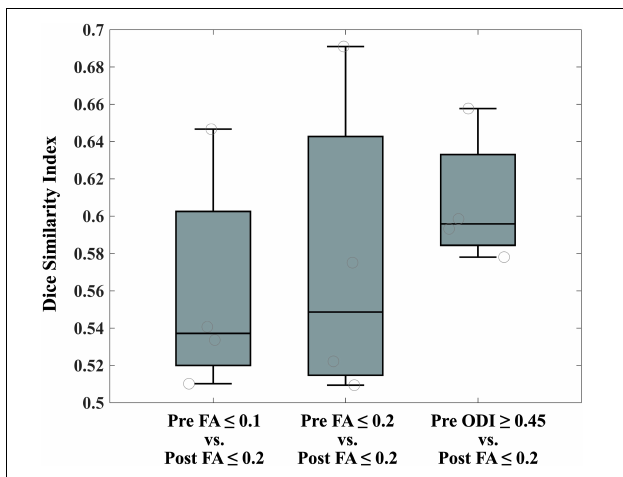
FIGURE 10 | The similarity comparison of CST reconstruction between pre- and post-surgery. CST, corticospinal